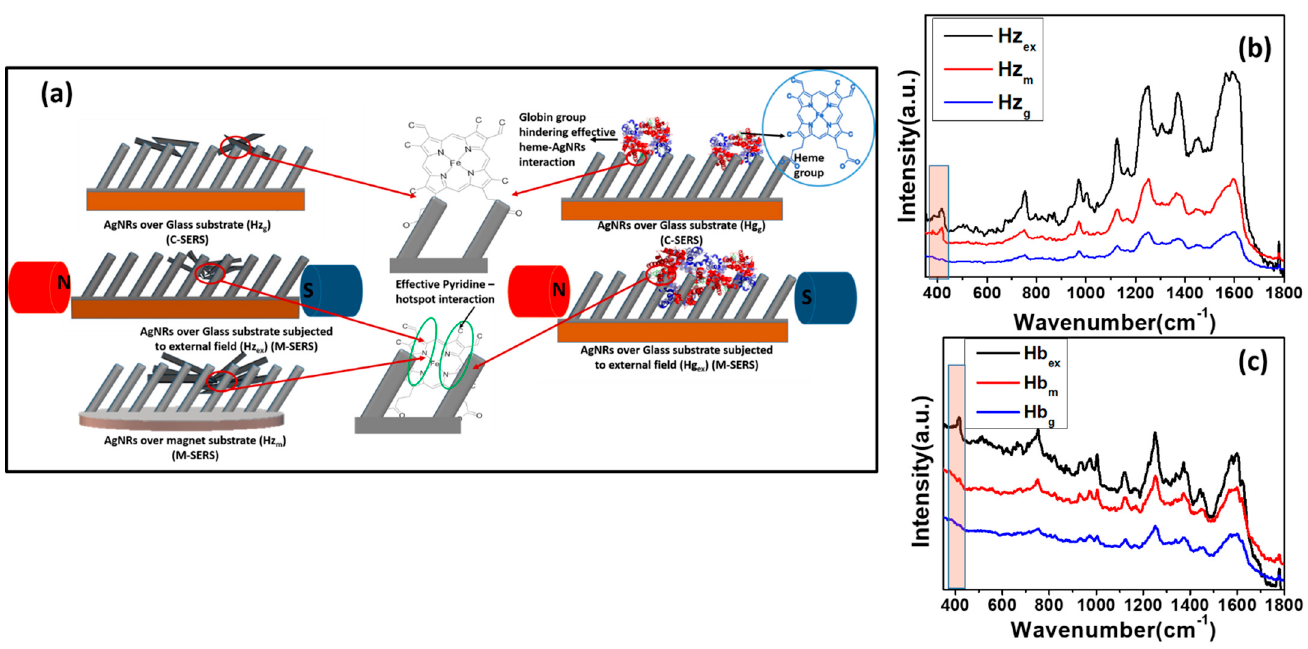
Figure 10. ( a ) Schematic diagram showing pyridine–AgNR interactions for the unmagnetized Hz and Hg over AgNS substrate (c-SERS), in the presence of a magnetic field (M-SERS). ( b ) Comparison of SERS spectra for Hz on AgNR arrays fabricated over glass (Hz g ) (neodymium magnet (Hz m ), Hz g substrate kept at 0.3 T external magnetic field for 1 h (Hz ex )) and ( c ) Hg on AgNR arrays fabricated on glass (Hb g ) (neodymium magnet (Hb m ), Hb g substrate kept at 0.3 T external magnetic field for 1 h (Hb ex )). Reproduced with permission from